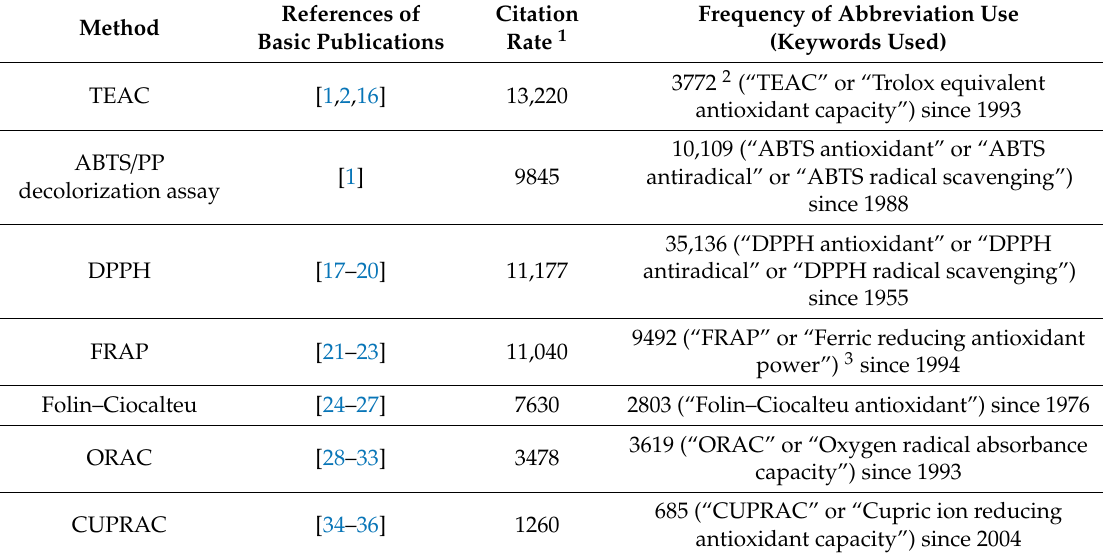
Table 1. The citation rates of the most widely used antioxidant activity / antioxidant capacity (AOA / AOC) methods and frequency of abbreviation usage. Data are from the Scopus